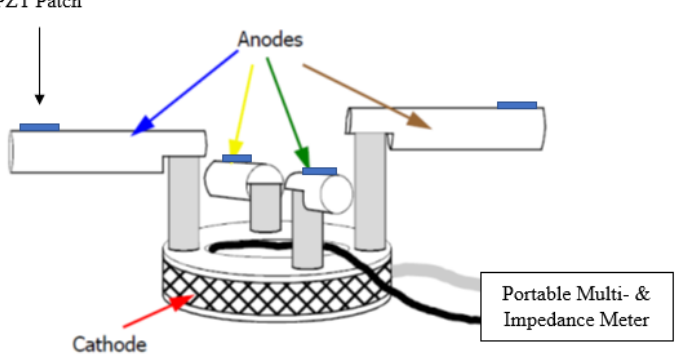
Figure 21. Electromechanical impedance, Voltage and Current measurements using a modified Cor- roWatch.